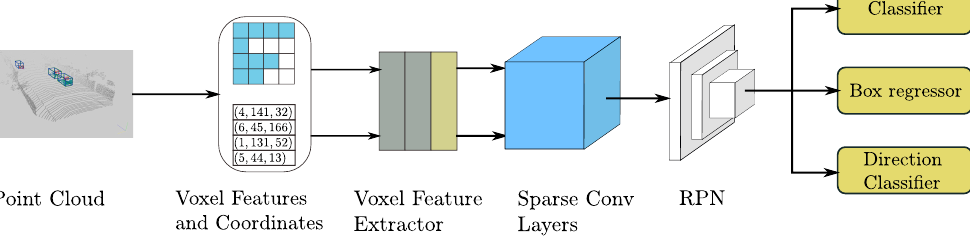
Figure 1. The structure of our proposed SECOND detector. The detector takes a raw point cloud as input, converts it to voxel features and coordinates, and applies two VFE (voxel feature encoding) layers and a linear layer. Then, a sparse CNN is applied. Finally, an RPN generates the